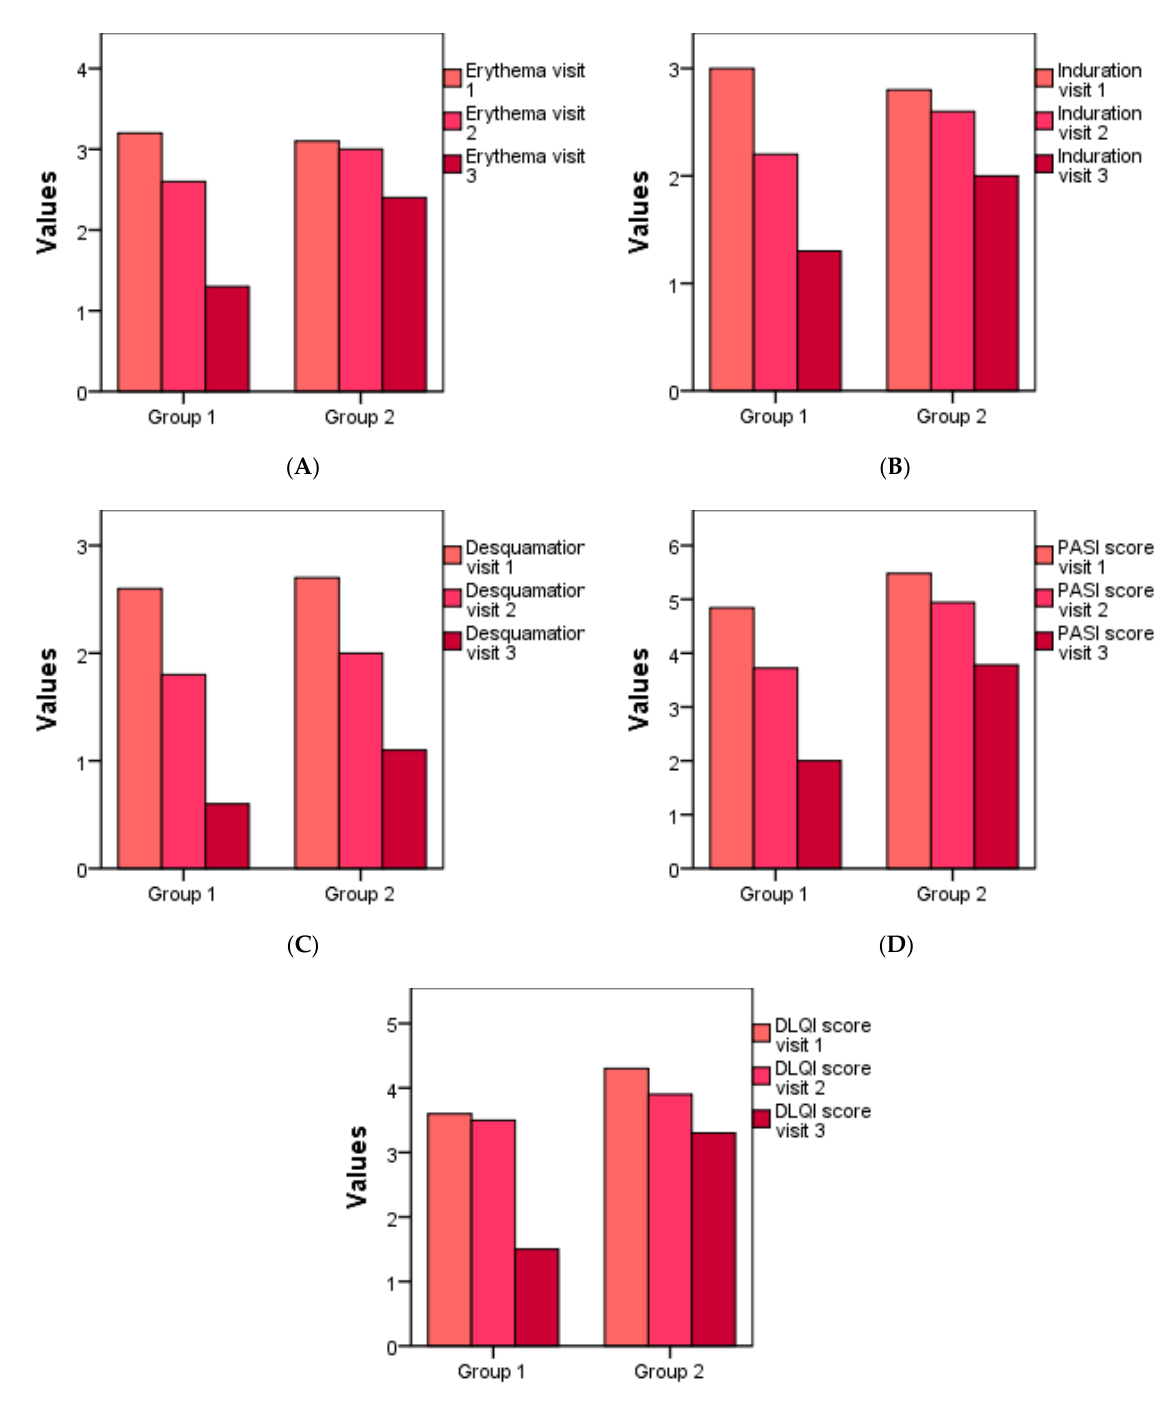
Figure 8. Nominal graphical presentation of the research parameters in the 3 visits, erythema (redness) ( A ), induration (thickness) ( B ), desquamation (scaling) ( C ), PASI Score ( D ), DLQI score ( E ), in the 2 research groups. The treated group is represented by Group 1 and the placebo group is represented by Group